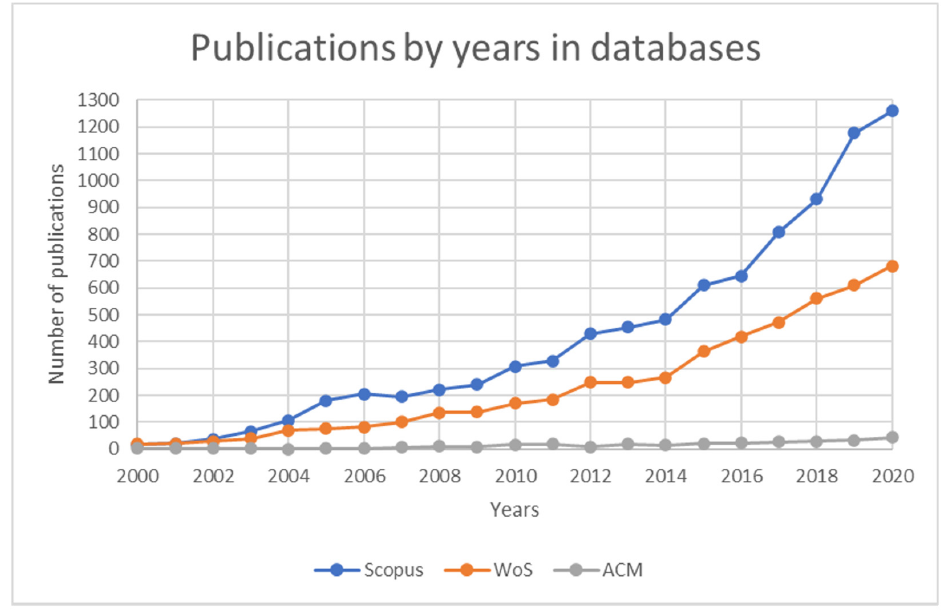
Figure 4. Publications in various databases based on e-waste keywords search.